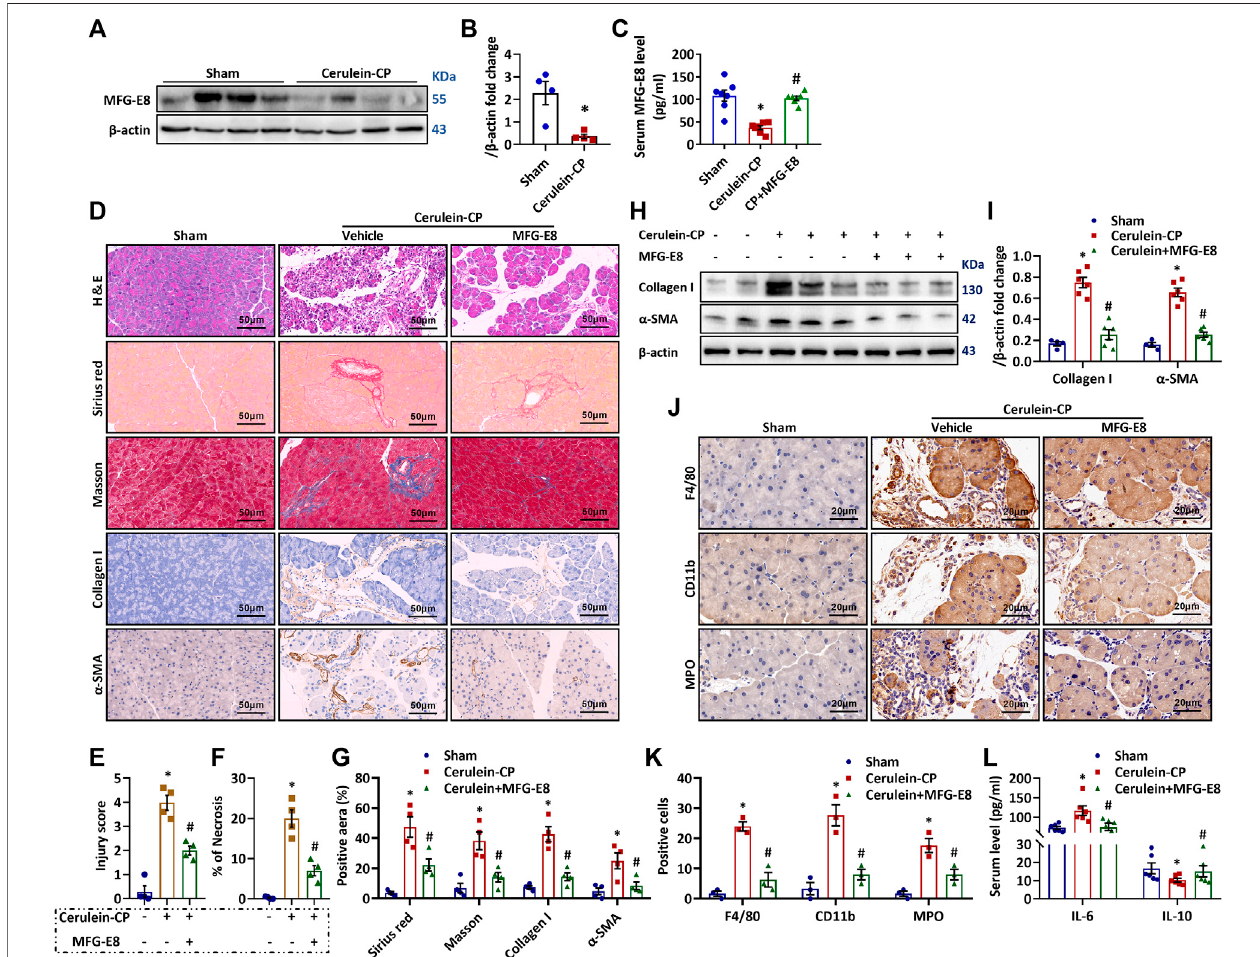
FIGURE2 |TherapeuticPotentialofExogenousMFG-E8. Cerulein-CPwasinducedbysixIPinjectionsofcerulein(50 μ g/kg/bodyweight)twiceaweekfor10 weeks. Duringthelast5 weeks,1 hafterceruleininjection,normalsaline(vehicle)or20 μ g/kgMFG-E8wasadministeredthroughintraperitonealinjection.Thecontrolgroupreceivedthe same frequency and time of intraperitoneal injection of normal saline (Sham). The animals were sacri fi ced at 2 days after the last injection of cerulein or normal saline. Blood and tissuesampleswerecollected. (A,B) WesternblotanalysisoftheexpressionofMFG-E8inthepancreas( t -test); (C) SerumMFG-E8levels(one-wayANOVAwiththeTukey- Kramer test); (D) Representative photos of H&E, Sirius red, Masson, Collagen I and α -SMA staining; (E) Quantitative analysis of H&E staining (one-way ANOVA with the Tukey- Kramertest); (F) Percentagesofnecroticareas(one-wayANOVAwiththeTukey-Kramertest); (G) QuantitativeanalysisofSiriusredMasson,CollagenIand α -SMAstaining(one- wayANOVAwiththeTukey-Kramertest); (H,I) Westernblotanalysisoftheexpressionof α -SMAandcollagenIinthepancreas(one-wayANOVAwiththeTukey-Kramertest); (J) RepresentativephotosofF4/80,MPOandCD11bstaining; (K) QuantitativeanalysisofF4/80,MPOandCD11bstaining(one-wayANOVAwiththeTukey-Kramertest); (L) Serum levels of IL-6 and IL-10 (one-way ANOVA with the Tukey-Kramer test). n (cid:1) 4 – 6, mean ± SEM; p p < 0.05 versus Sham group; # p < 0.05 versus Vehicle group. CP, chronic pancreatitis; MFG-E8, Milk Fat Globule-EGF Factor 8; H&E, hematoxylin and eosin; MPO, myeloperoxidase; α -SMA, alpha-smooth muscle actin.